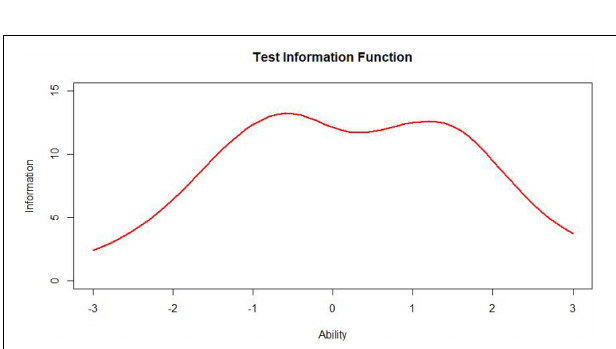
FIGURE 9 | Bimodally distributed test, information, function